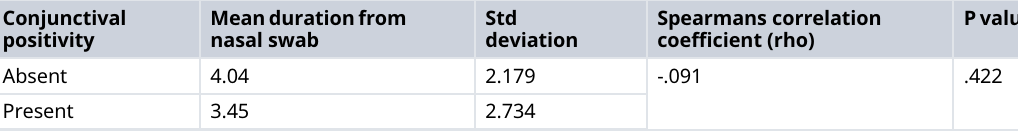
Table 5. Correlation between conjunctival positivity and duration from nasal